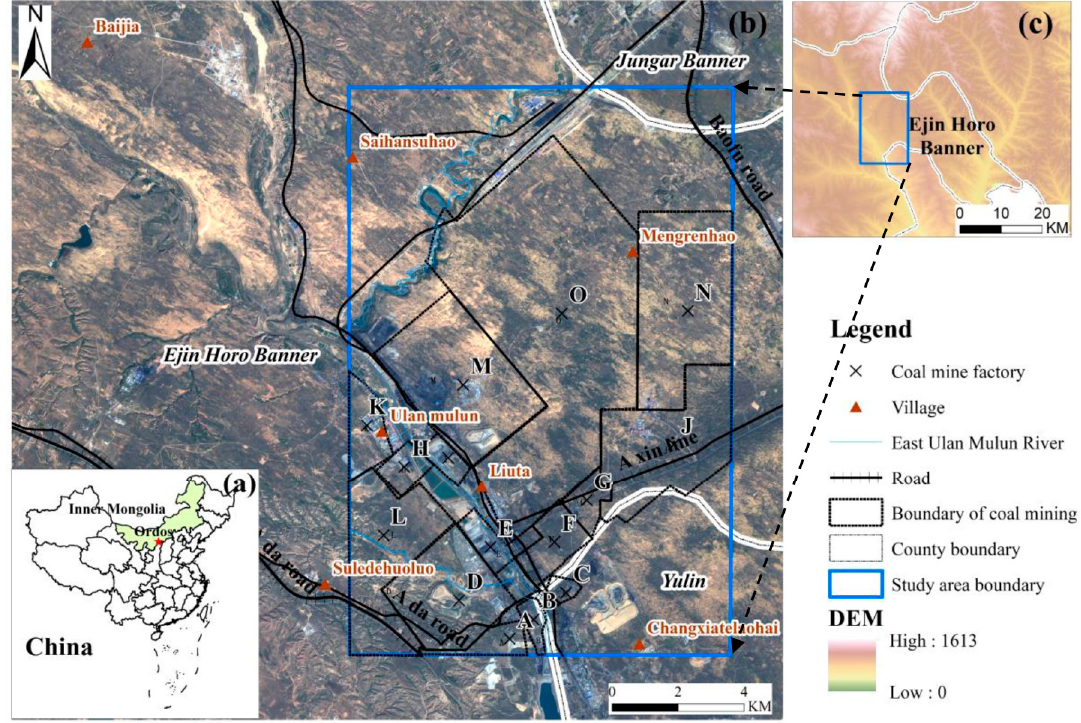
Figure 1. ( a ) Study area position on the map of China with the location of Ordos marked with a red star; ( b ) the geographic location of the study area is indicated by the blue polygon, which is superimposed on the SPOT-6 image obtained in 2015; ( c ) the elevation of study area in Ejin Horo Banner, Ordos, Inner Mongolia Autonomous Region.